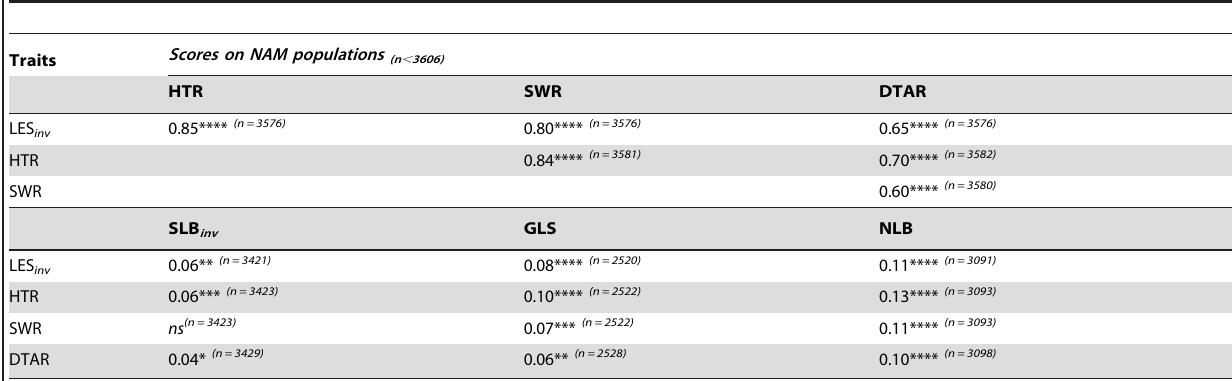
Table 2. Correlation coefficients between mean values of NAM RILs for lesion mimic traits and disease resistance score values obtained from previous studies (SLB, Kump et al. [34]; NLB, Poland et al. [35]; GLS, Benson [33]).